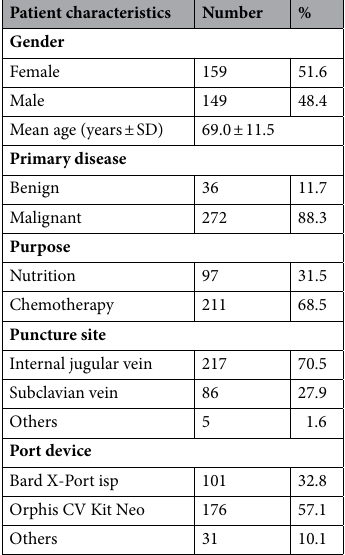
Table 1. Patient characteristics. SD standard deviation.